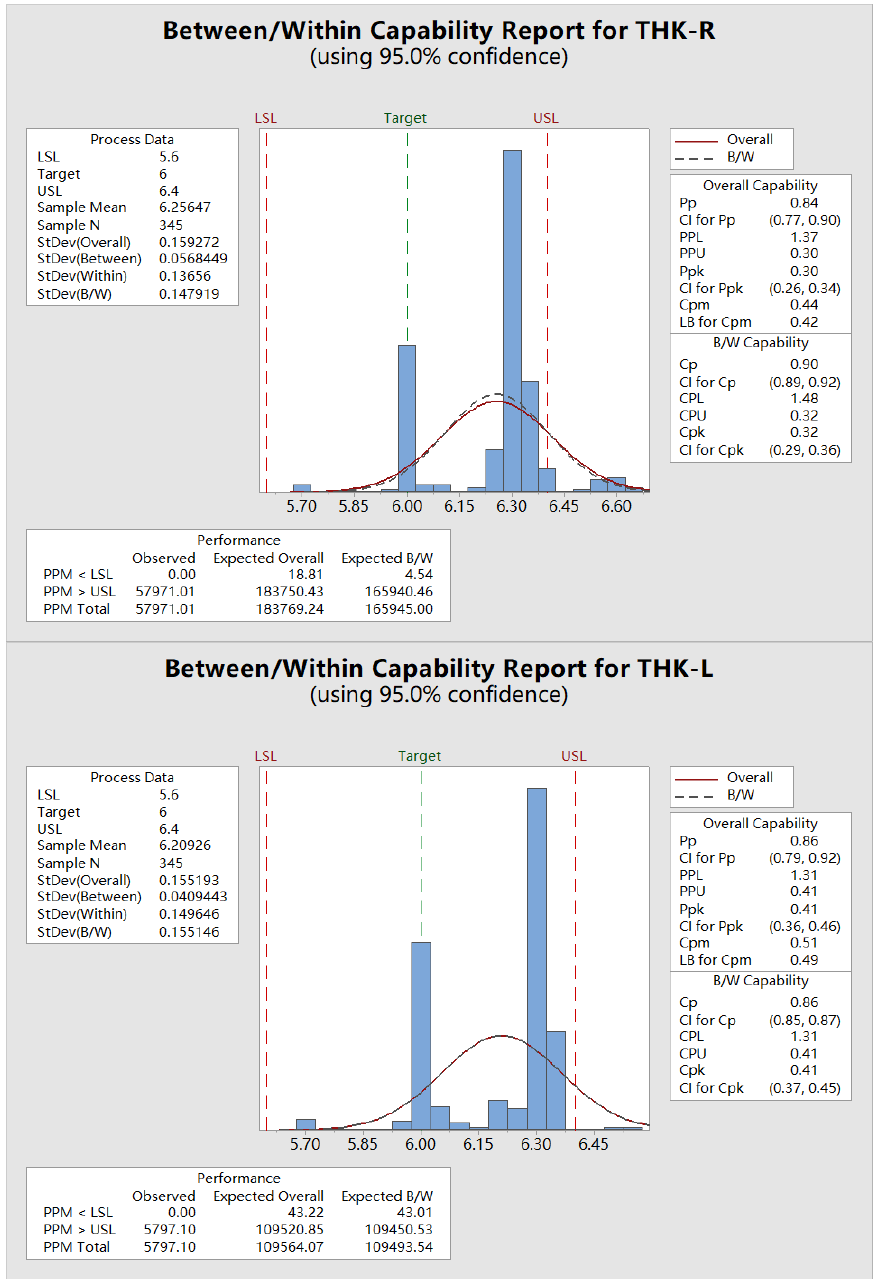
Figure 4. Thickness histograms for the 345 wafers for THK-B, THK-C, THK-T, THK-R and THK-L. LSL = 5.6 μ M, USL = 6.4 μ M and the target = 6.0 μ M.